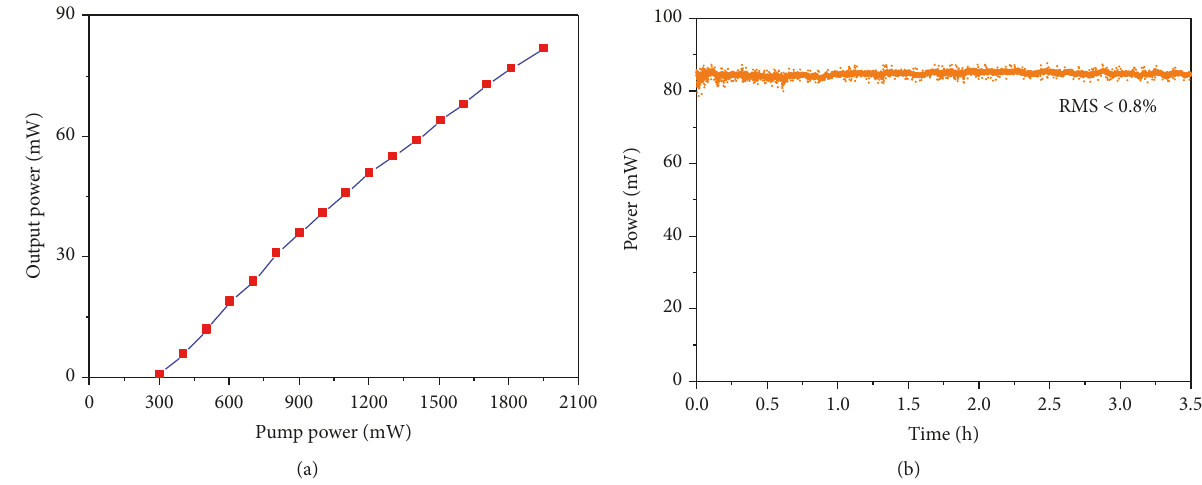
Figure 2: (a) Power scalable of the OPO output at degeneracy. (b) Long-term power stability of the maximum output power of the degenerate